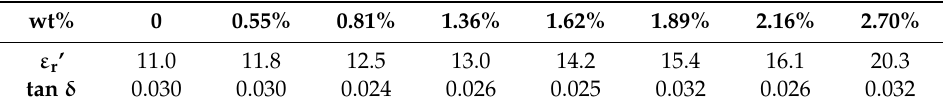
Figure 15. Relative dielectric permittivity ( ε r ’) ( a ), loss tangent (tan δ ) ( b ), and AC conductivity ( σ ’) ( c ) of P(VDF-CTFE)/rGO-IL composites as a function of frequency at RT with different compositions. Table 5. Relative dielectric permittivity ( ε r ’) and loss tangent (tan δ ) of composites with different rGO-IL loadings at 1 kHz and RT.